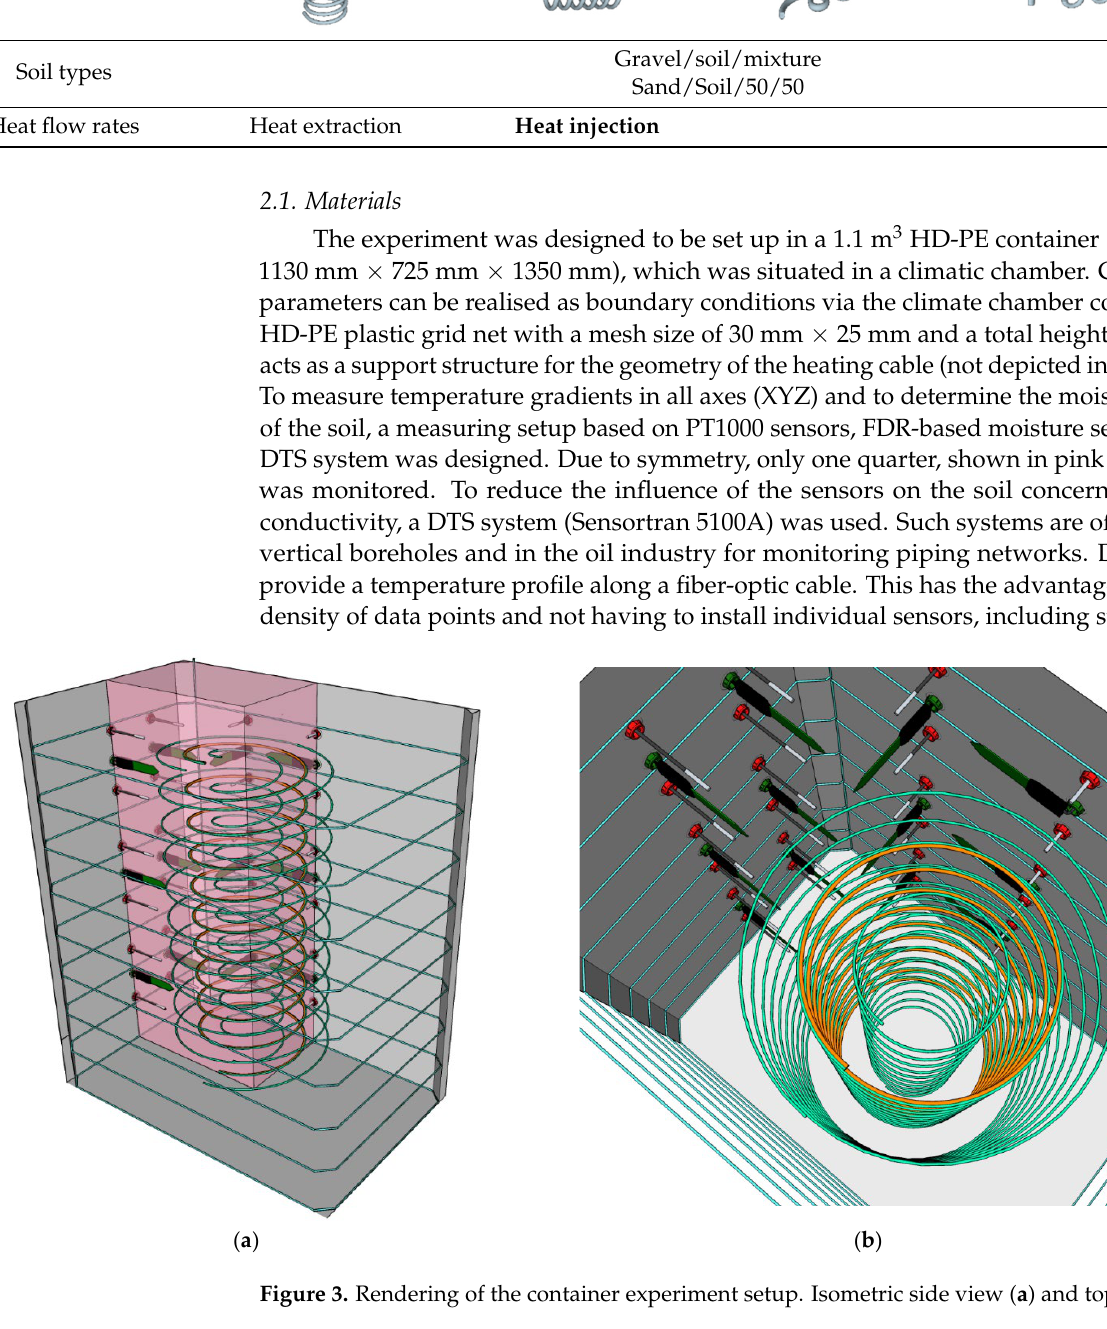
( b ) Figure 4. Laboratory experimental setup during the buildup process. PT1000 ( a ) and SMT100 ( b )